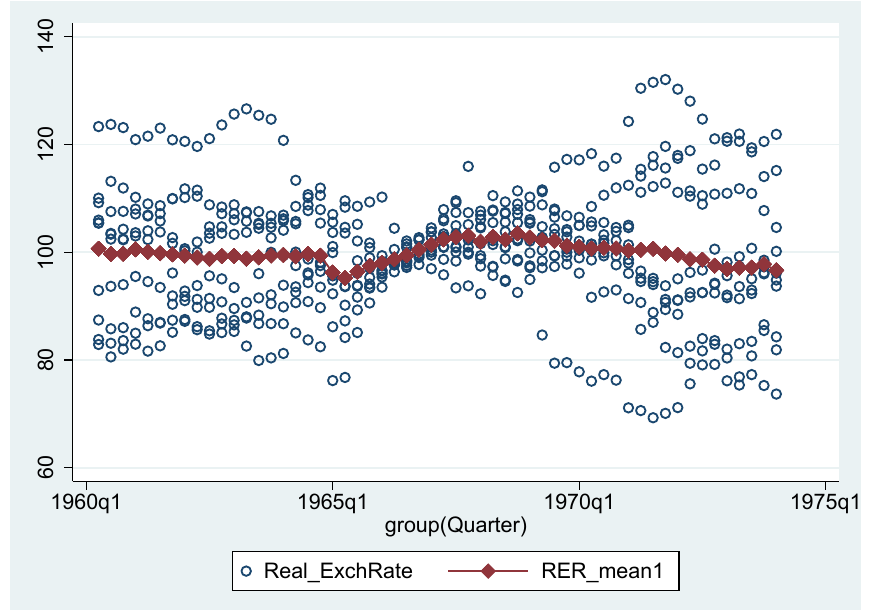
Figure A2. Scatter Plot for Time Effects.